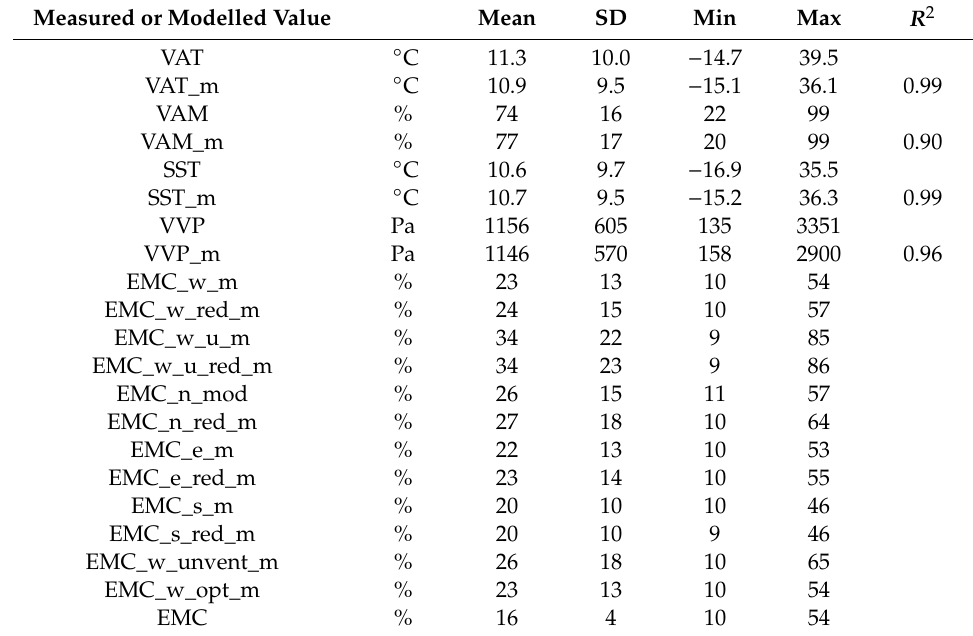
Table 3. Descriptive statistics of modelled values and correlations with measured